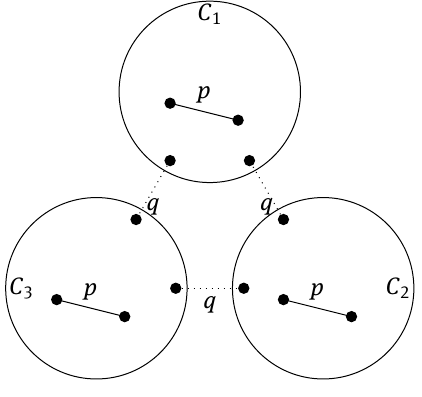
Figure 1: An illustration of the planted partition model. Edges between two vertices in the same cluster are added with proba- bility p , while edges between two vertices in different clusters are added with probability q